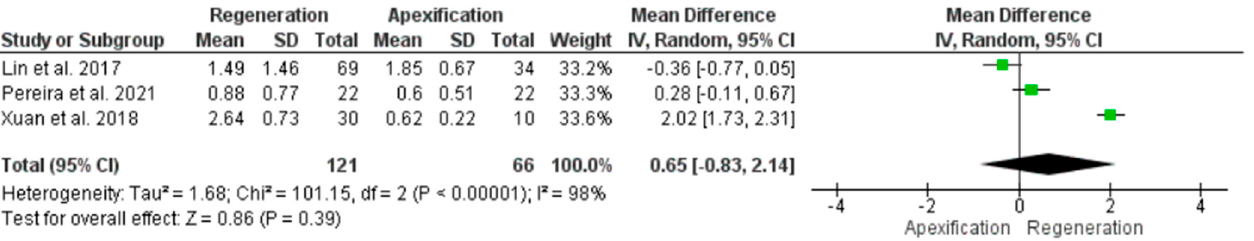
Figure 14. Meta-analysis of apical foramen width (AFW) in young immature teeth treated with regenerative endodontic procedure (REP) or apexification procedure.